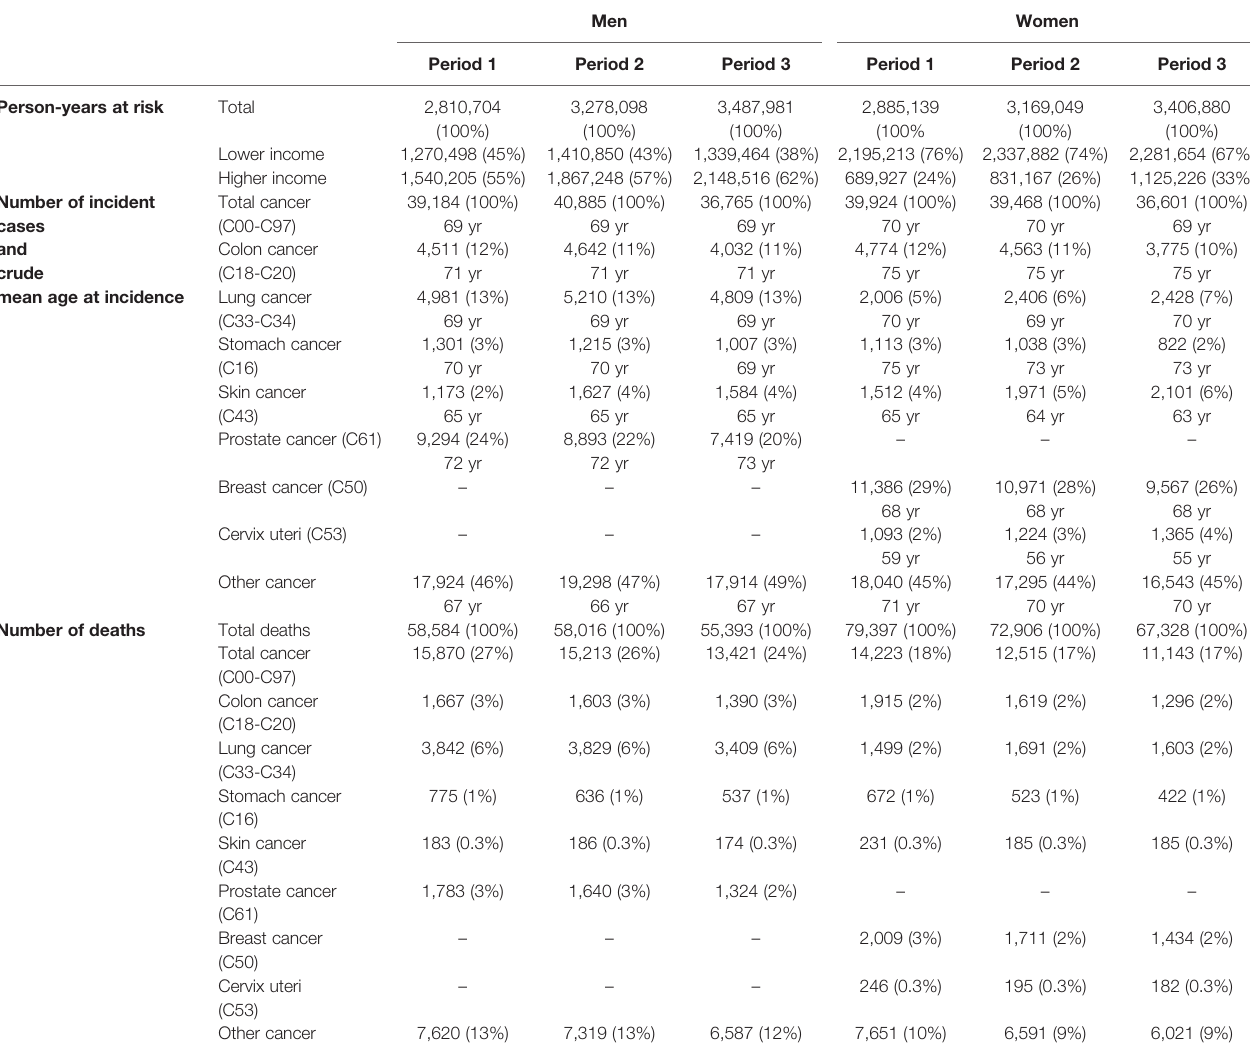
TABLE 1 | Characteristics of the study population aged 20 and older: exposures in person-years, number of death cases, and number of incident cases by sex and time